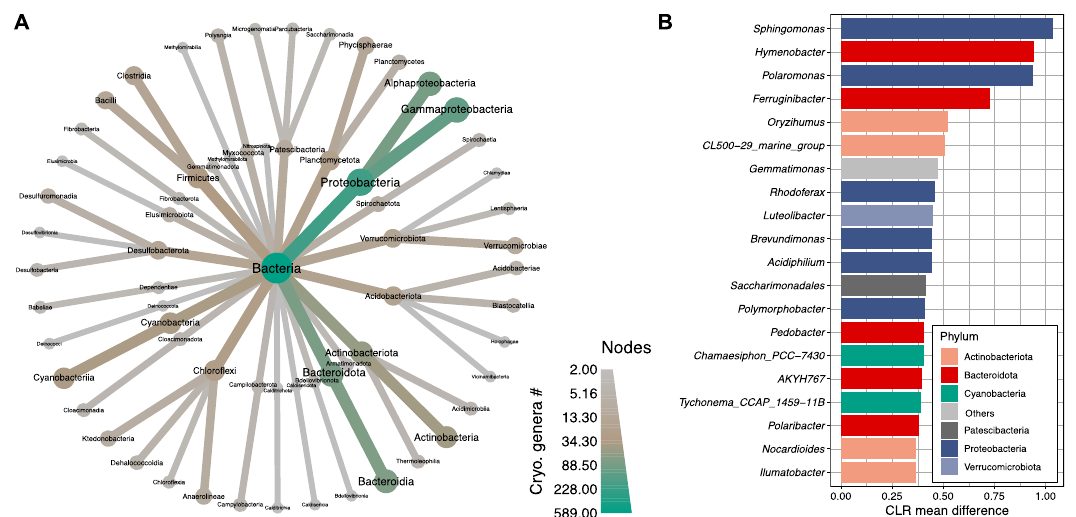
Fig. 2 Cryospheric genera and shared genomic properties. A Taxonomic tree representing the number of cryospheric genera per taxon with colours. Only taxa containing at least two cryospheric genera are shown (down to the class level). B Bar plot showing the bacterial genera signi fi cantly enriched in the cryosphere with the highest centered log-ratio (CLR) mean difference (based on ANCOM analysis). The colours represent the phylum level taxonomic classi fi cation. Source data are provided as a Source Data fi